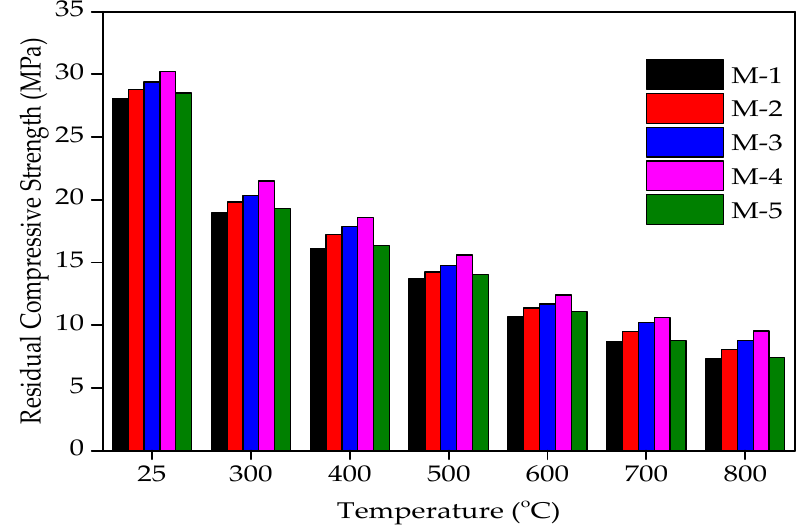
Figure 7. Residual compressive strength (RCS) of WFS concrete at various temperature levels.